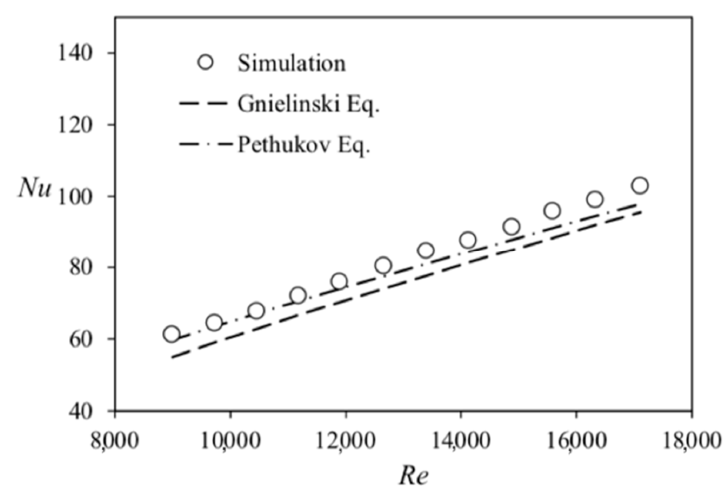
Figure 3. Nusselt number validation for plain tube. Energies 2018 , 11 , x FOR PEER REVIEW